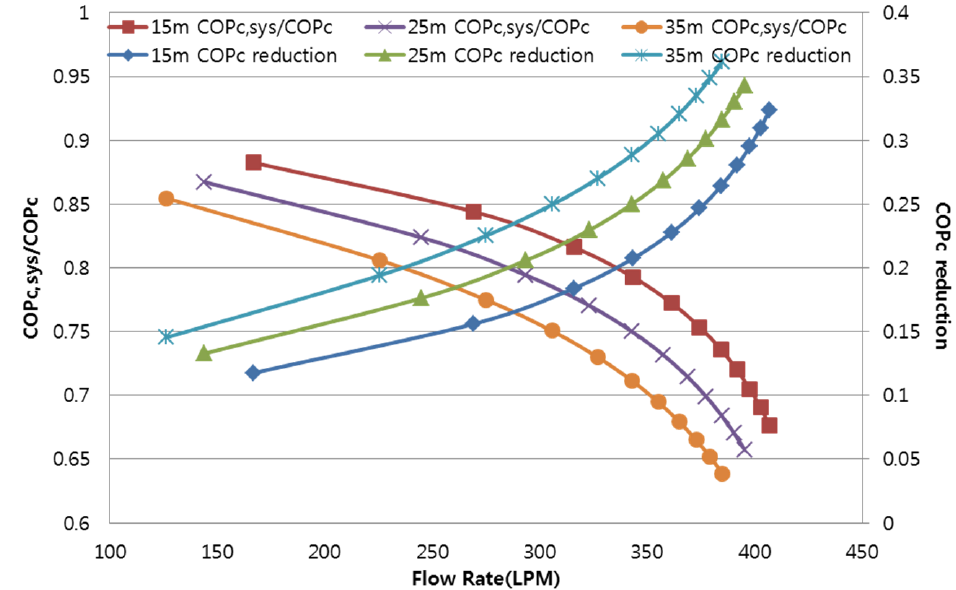
Figure 7. System cooling COP reduction compared to heat pump unit COP.